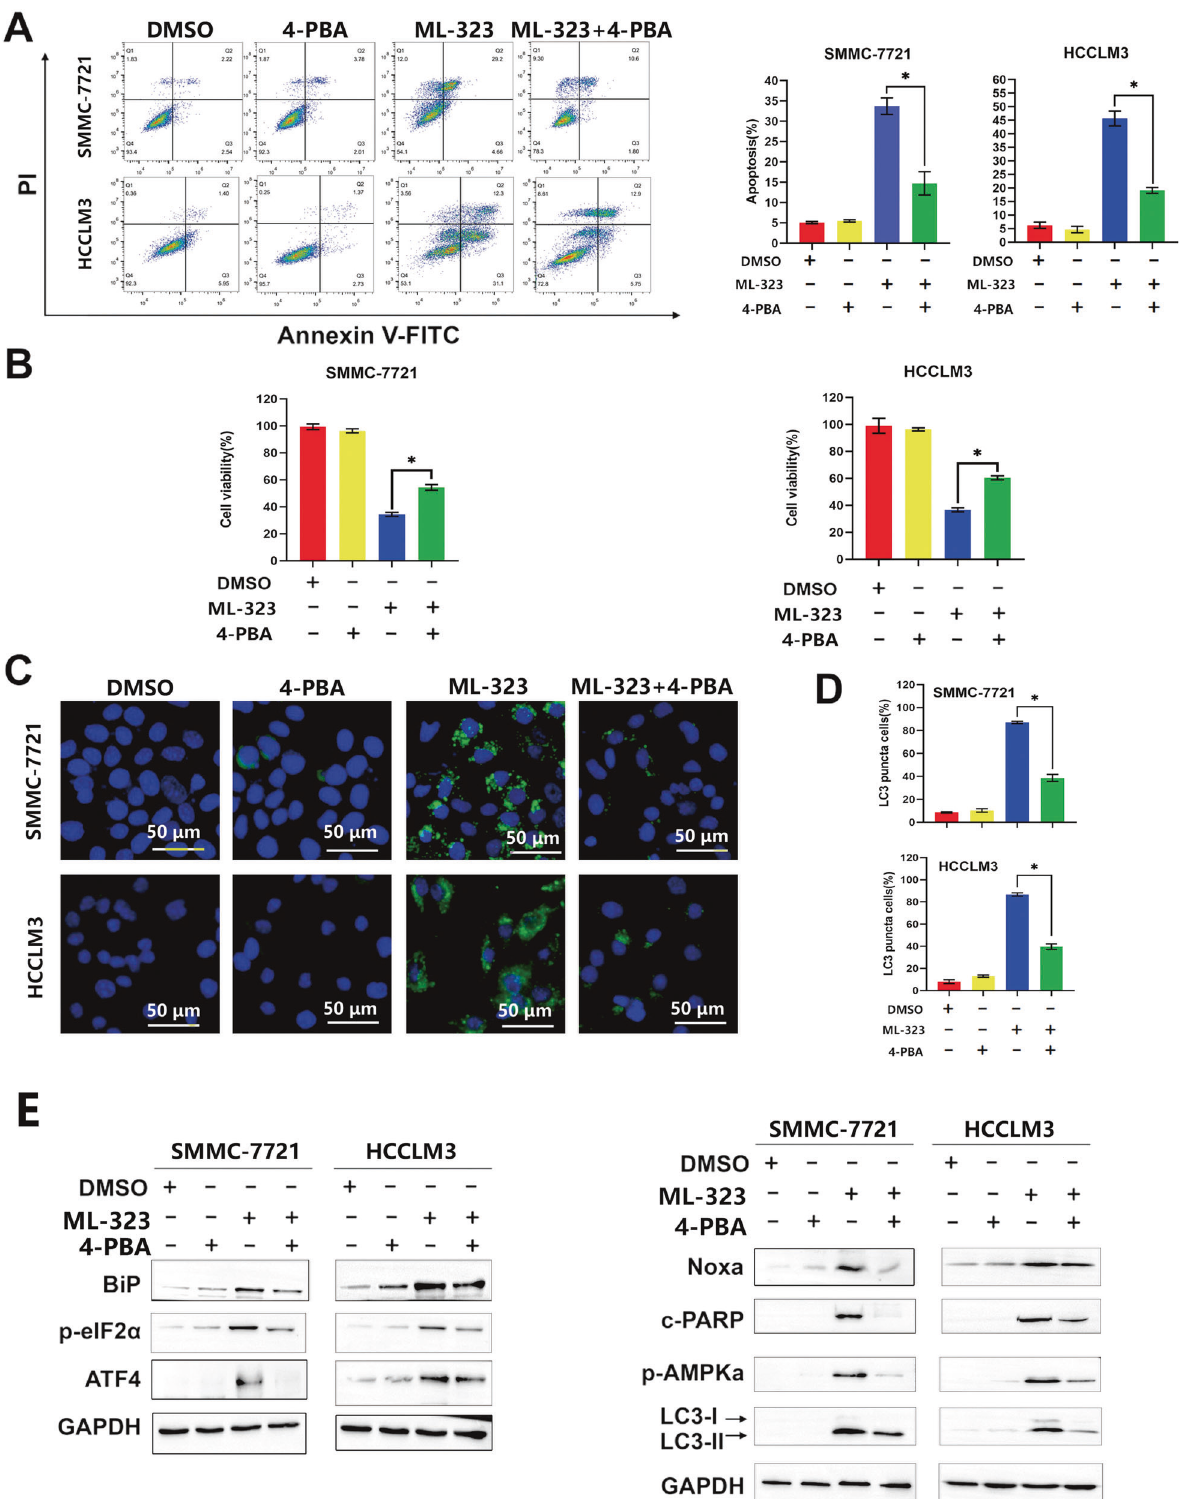
Fig. 6 ML-323 induces ER stress in human HCC cells. A Flow cytometry analysis using an Annexin V-FITC/PI double-staining kit to detect apoptotic HCC cells. HCCLM3 and SMMC-7721 were cells treated with ML-323 alone or in combination with DMSO and an ER stress inhibitor (4-PBA). B Cell-counting kit-8 assay showing the viability of HCCLM3 and SMMC-7721 cells treated with ML-323 alone or in combination with DMSO and 4-PBA. Blocking ER stress alleviates the ML-323-induced inhibition of cell viability. C LC3B immuno fl uorescence staining in HCCLM3 and SMMC-7721 cells treated with ML-323 alone, or in combination with DMSO or 4-PBA. D LC3B puncta cells were statistically analyzed. E Western blot analysis of HCCLM3 and SMMC-7721 cells treated with ML-323 alone or in combination with DMSO or 4-PBA. Data are representative of at least three independent experiments ( n = 3; error bars, SD). All data were representative of at least three independent experiments ( n = 3; error bar, SD). Cell Death and Disease (2022)